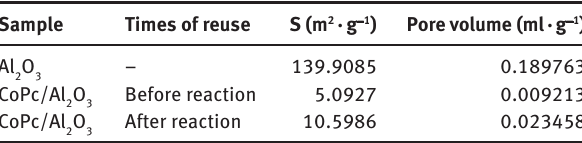
Table 1: Texture parameters for the mesoporous materials before and after anchoring with CoPc